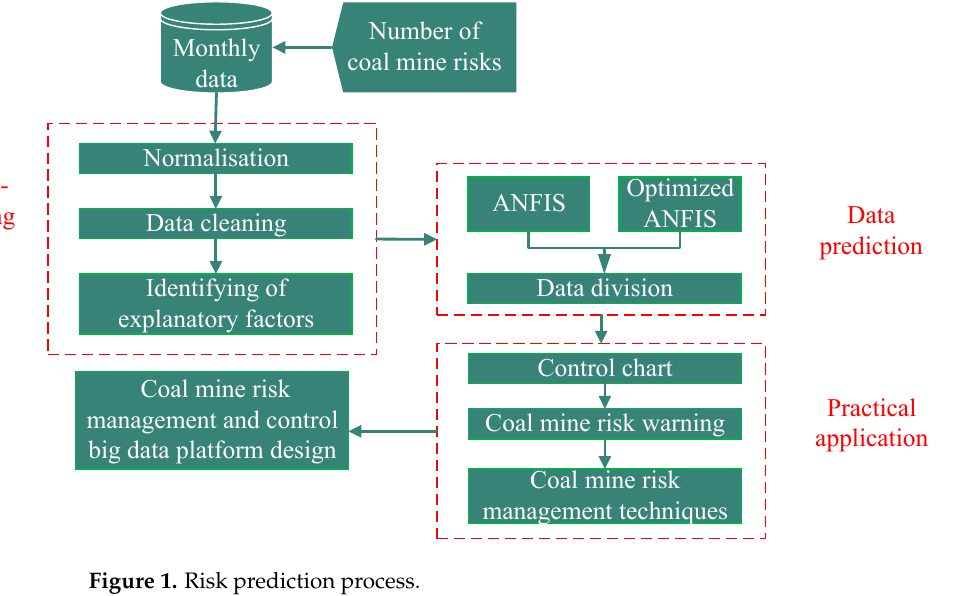
Figure 1. Risk prediction